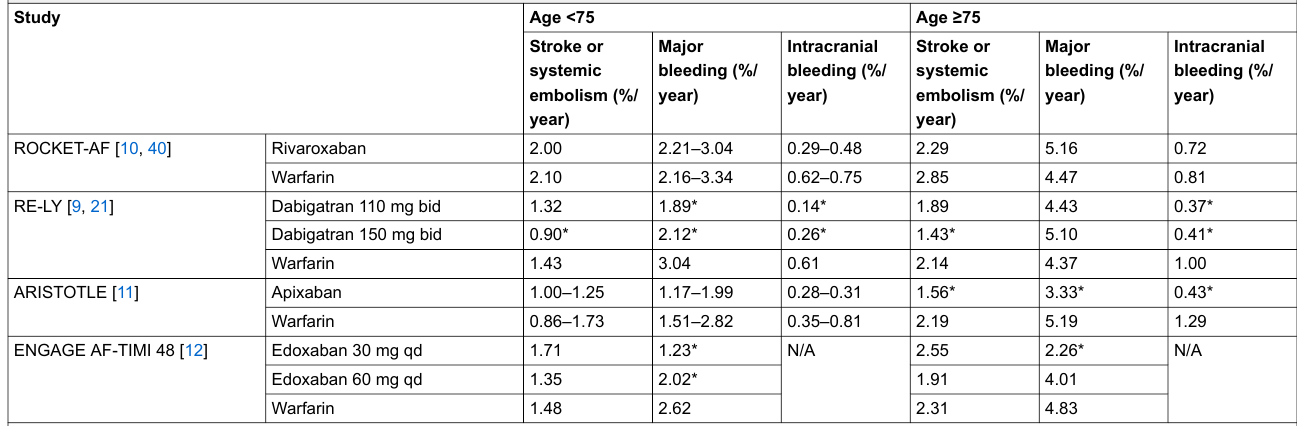
Table 3: Efficacy and safety of direct oral anticoagulants in elderly patients with atrial